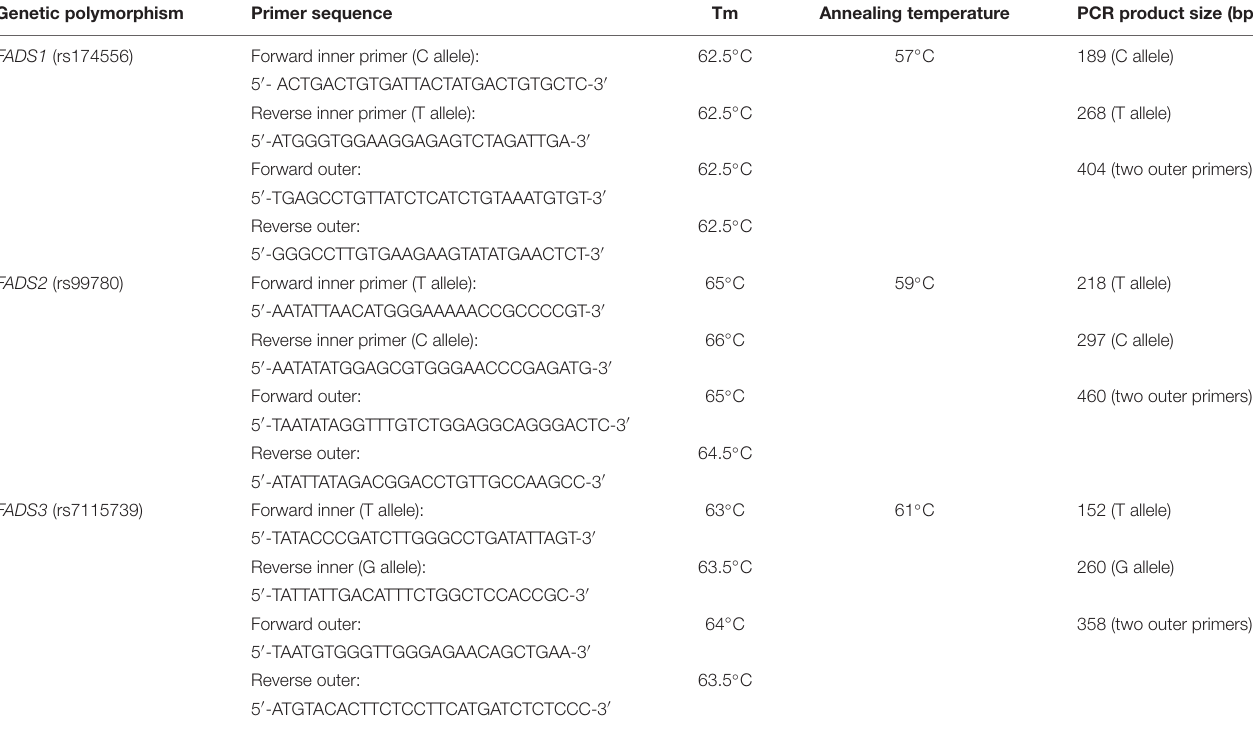
TABLE 2 | Primer sequences and PCR conditions for genotyping experiments. Genetic polymorphism Primer sequence Tm Annealing temperature FADS1 (rs174556)